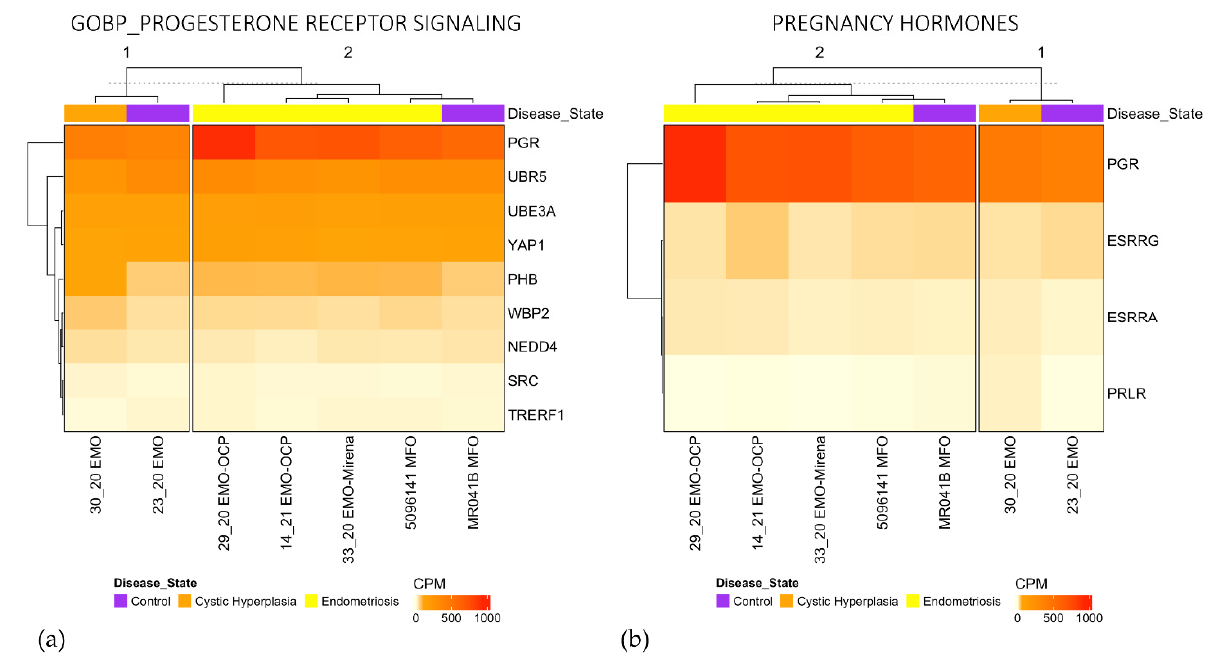
Figure 4. Gene expression profile of MFO, EMO-H, and EMO determined by RNAseq. PCA plot ( a ) of top 1000 genes expressed by MFO, EMO − H, and EMO. MFO (red), EMO (blue), and EMO − H (green) did not cluster separately. Controls (dotted) clustered separately on PC1 only. Venn diagram ( b ) showing the majority of the top 1000 expressed genes were shared by MFO, EMO-H, and EMO. Normalised SSEA-1 expression ( c ) was increased in two of the four women with endometriosis.